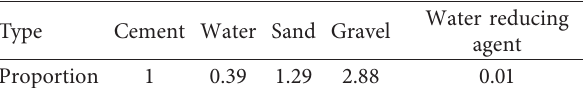
Figure 2: Section diagram of the TCFST column. Table 2: Concrete mix proportion.